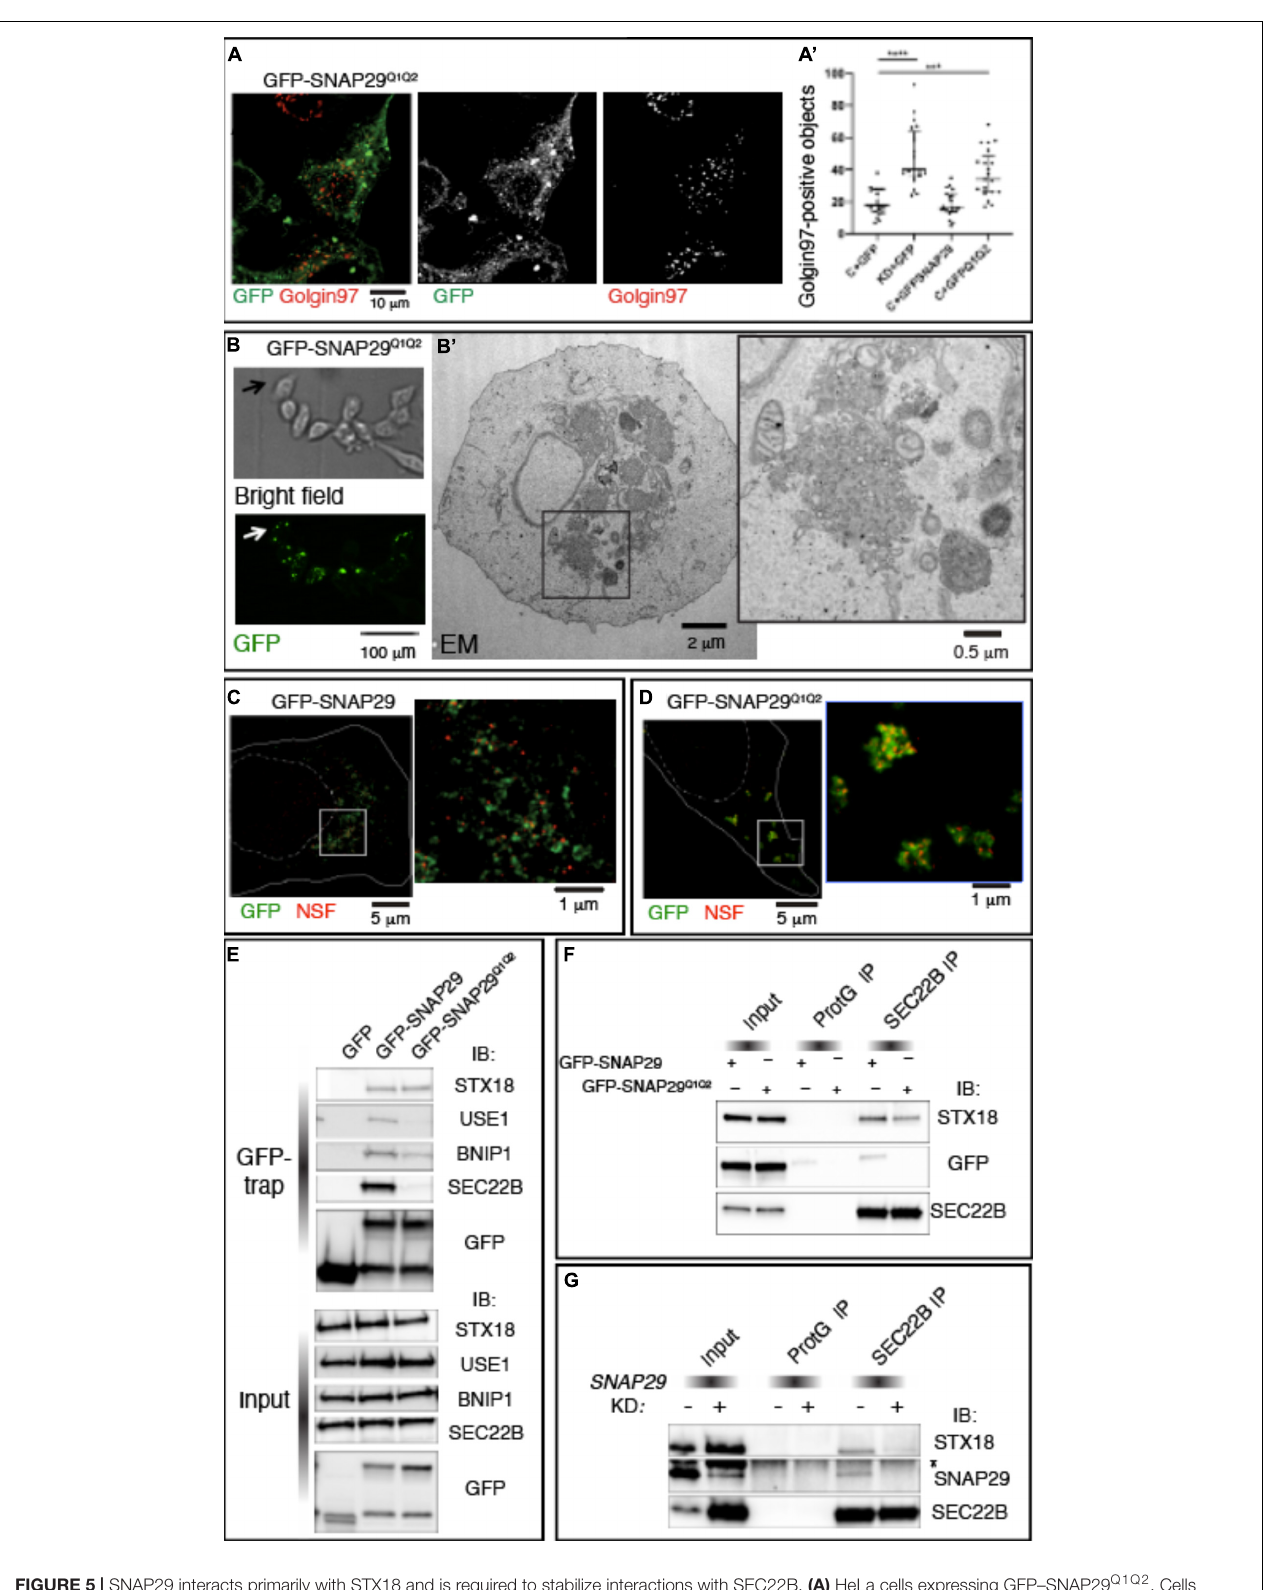
FIGURE 5 | SNAP29 interacts primarily with STX18 and is required to stabilize interactions with SEC22B. (A) HeLa cells expressing GFP–SNAP29 Q1Q2 . Cells stained with anti-Golgin97 to mark the Golgi apparatus (GA) show that GFP–SNAP29 Q1Q2 forms enlarged bodies at the cell periphery and that the GA is fragmented. (A’) Quantification of Golgin97-positive GA object upon expression of the indicated transgenes reveals that GFP–SNAP29 Q1Q2 induces GA